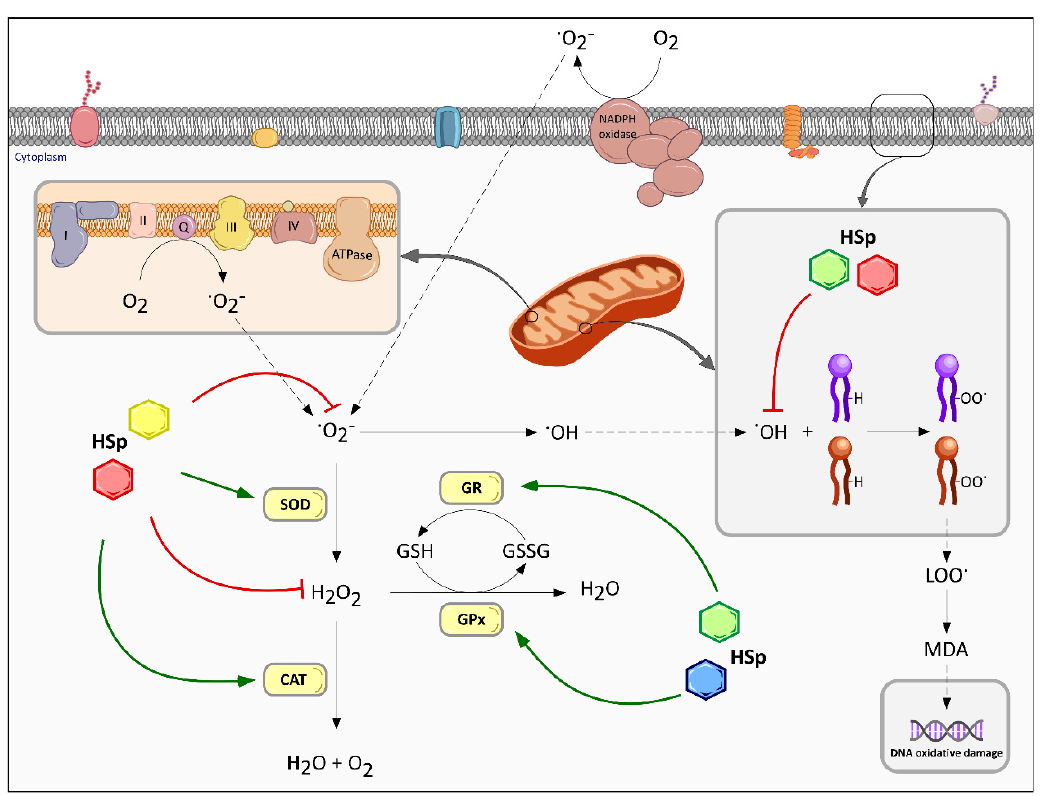
Figure 3. Multiple effects of HS polyphenols on intracellular redox homeostasis. The antioxidant abilities of HS polyphenols (HSp), represented by colored hexagons, act directly or indirectly upon intracellular ROS generation in oxidative status. HSp may directly react with ROS and free radical intermediates by halting the chain reaction, thereby stopping the ROS-induced damage. HSp antioxidant activity blocks intracellular ROS generation in hydrophilic environments and also the generation of lipoperoxy radicals, which are major responsible for DNA oxidative damage. Alternatively, HSp may act indirectly by up-regulating antioxidant enzymes expression or protein activation. SOD, superoxide dismutase; CAT, catalase; GPx, glutathione peroxidase; GR, glutathione reductase. Different colors of HSp symbols indicate different families or structural moieties of polyphenols’ metabolites.